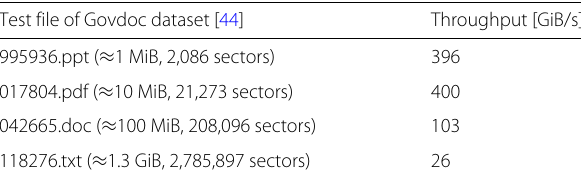
Table 8 Average query throughput of Algorithm 4 with random sampling ( p > 0.99)